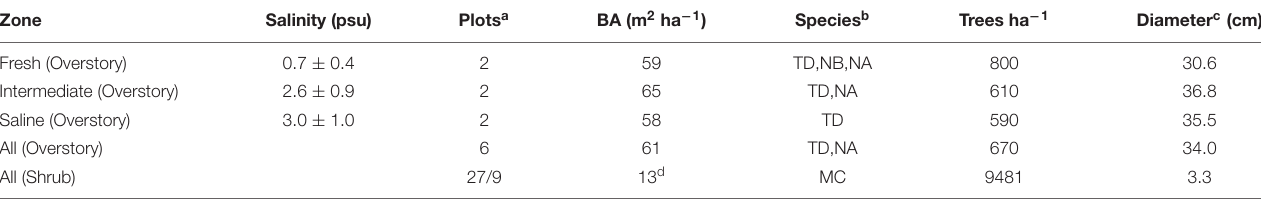
a For overstory measurements, 20 × 25 m plots were used; for the shrub midstory, 27 5.0 × 1.0 m plots were used to quantify tree ha-1 and nine hummocks of various size were used to characterize BA and diameter. b Taxodium distichum, Nyssa aquatica, Nyssa biflora, and Morella cerifera. c Quadratic-mean diameter. d In the nine